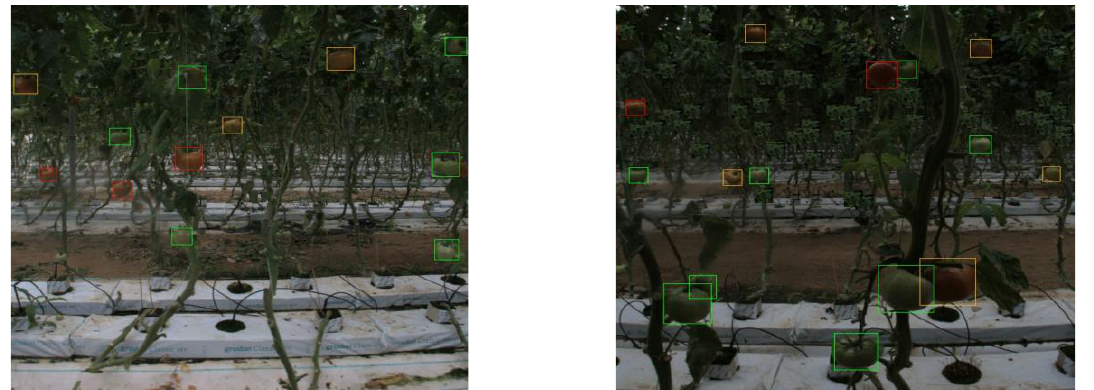
Figure 1. Sample images with annotations. Tomatoes below a certain size are considered out of scope. Green boxes are of class unripe, orange boxes of class semi-ripe and red boxes of class fully-ripe.